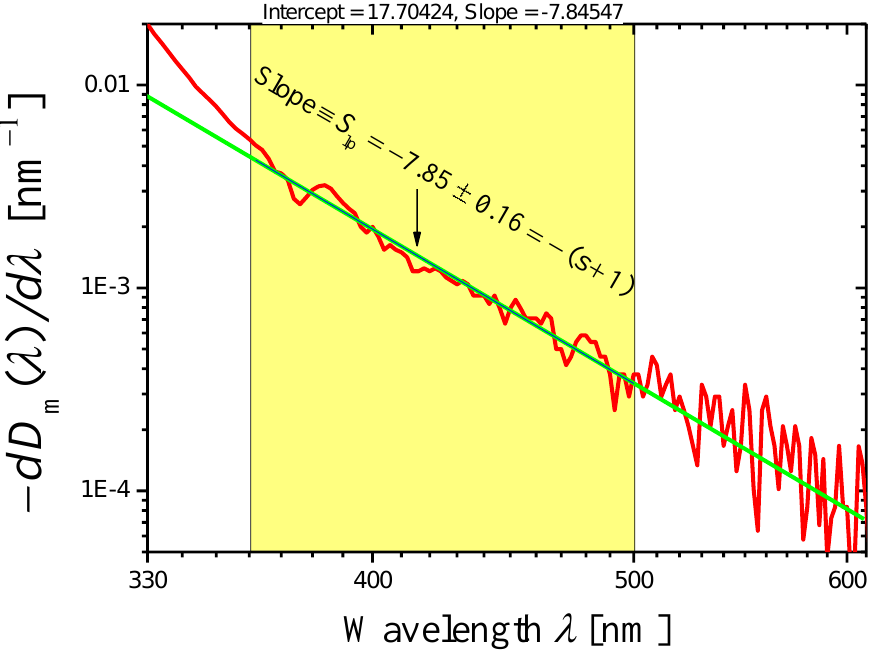
Figure 1. A log–log plot of the dependence of ( − dD m ( λ ) / d λ ) on λ constructed for the measured optical density D m ( λ ) of the glass G2 sample with the thickness h 2 = 10.00 mm (red curve). The green straight line presents the linear least squares approximation of the curve in the spectral range of 360 − 500 nm .